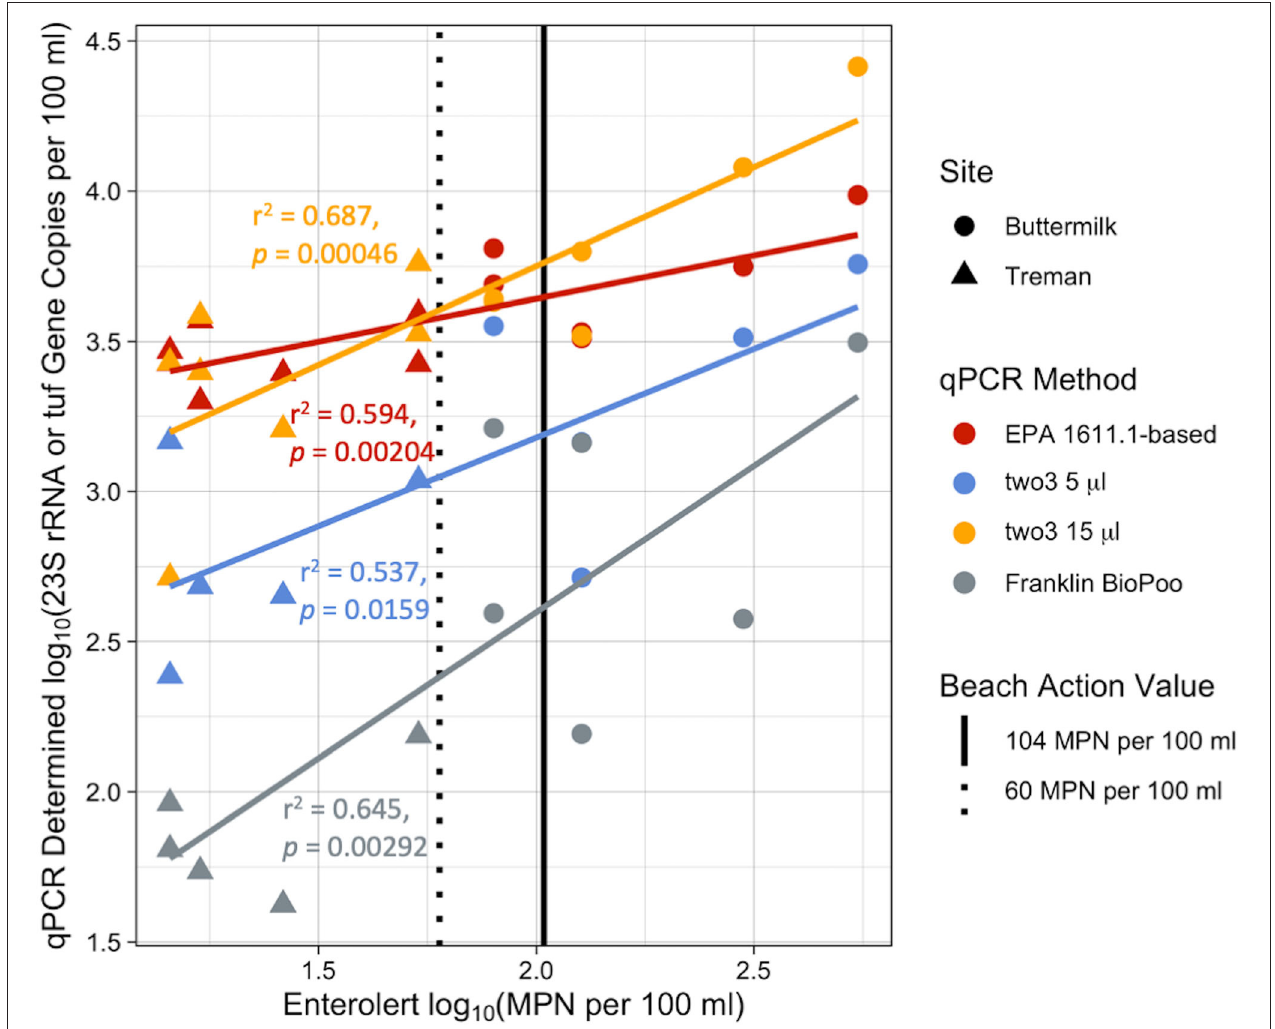
FIGURE 4 | Comparison of qPCR methods to Enterolert. log 10 -log 10 comparison of the Biomeme methods C1, C2, and C3 (two3-5 µ l, two3-15 µ l, and BioPoo, respectively) and EPA-based method with the standard culture-based method (Enterolert) currently used by beaches for fall 2017 Buttermilk (circle) and Treman (triangle) samples. The Biomeme method C1 and C2 and EPA-based methods quantify the 23S rRNA gene for Enterococcus , while the Biomeme method C3 (Franklin BioPoo) quantifies the tuf gene. Vertical lines denote beach action values (BAVs) used by different localities, the dotted black line represents a BAV of 60 MPN per 100ml and the solid line represents a BAV of 104 MPN per